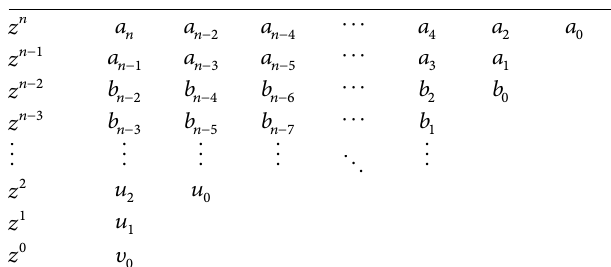
Table 1: The Routh’s